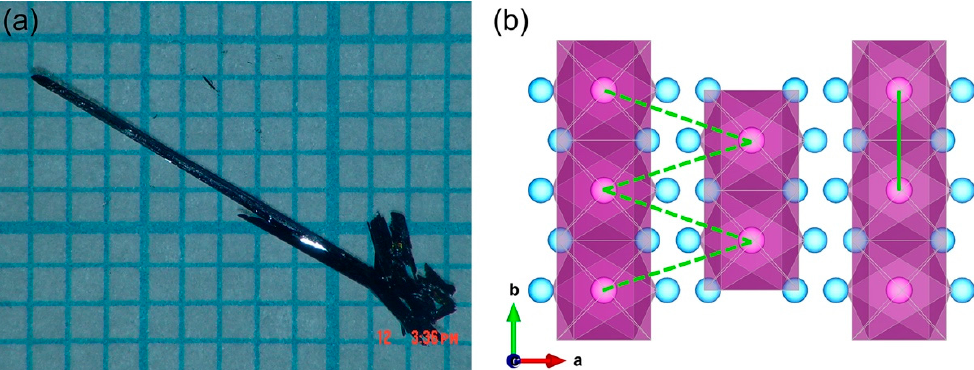
Figure 2. ( a ) A single crystal of MnBi 2 Se 4 grown by the chemical vapor transport (CVT) technique. The scale of the background paper is 1 mm. ( b ) The nearest intrachain (solid line) and interchain (dashed lines) Mn–Mn contacts in the crystal structure of MnBi 2 Se 4 , corresponding to the J 1 and J 2 magnetic exchange constants, respectively.